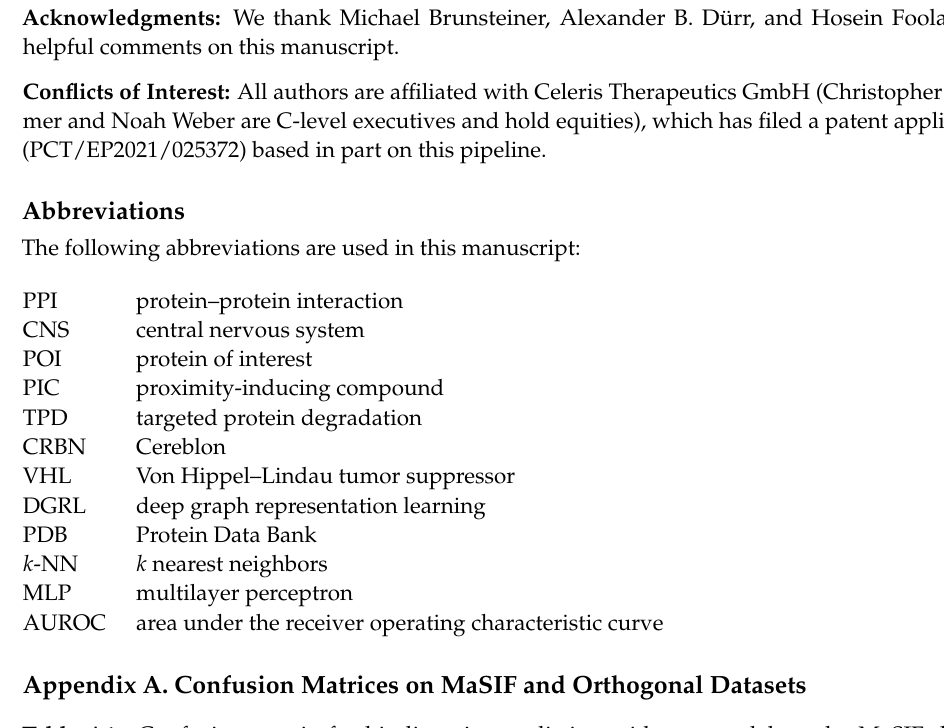
Table A1. Confusion matrix for binding site prediction with our model on the MaSIF dataset (achieving an AUROC of 0.82, see Table 2). True/false positives and true/false negatives are av- eraged across multiple different surfaces patches (see Section 2). The threshold was set to